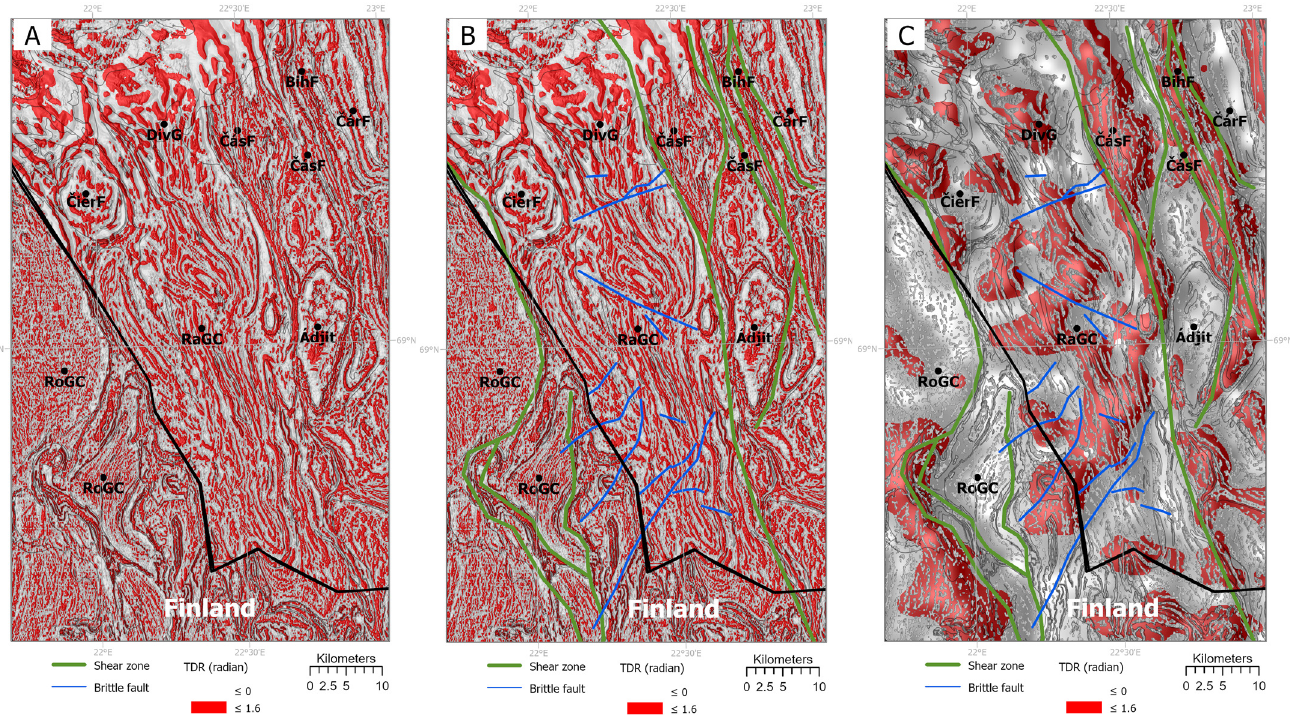
Figure 9. Tilt derivative maps from the western part of the study area (positive values are shown in red colour). (A) Tilt derivative of magnetic data without inter- pretations. (B) Tilt derivative of magnetic data with interpreted faults and shear-zones. (C) Positive values of tilt derivative from magnetic data overlaid on the gravity tilt derivative. BihF= Bihkkačohkka Formation, ČárF= Čáravárri Formation, ČásF= Čáskejas Formation, ČierF= Čierte Formation, DivG= Dividal Group, RaGC= Ráiseatnu Gneiss Complex, RoGC= Rommaeno Gneiss